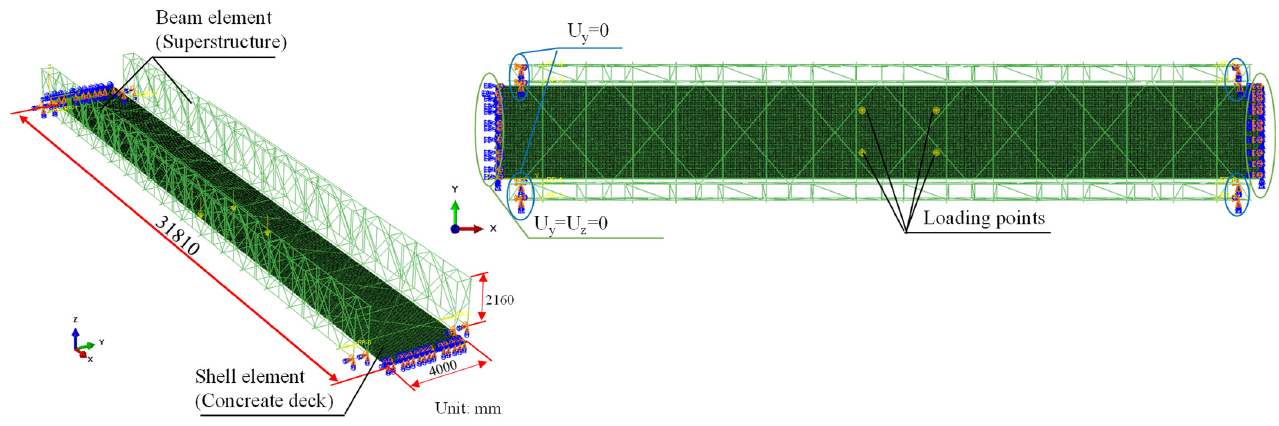
Figure 10. Analytical structural model. Table 2. Onsite Structural Dimensions.